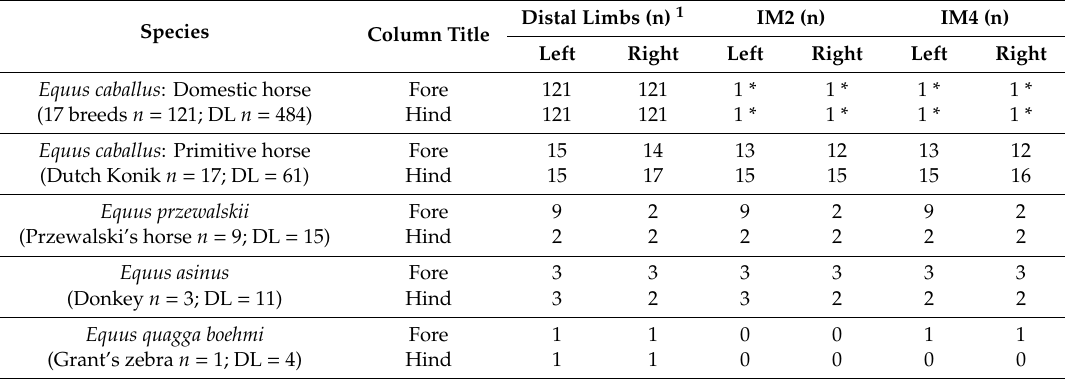
1 Note: Not all four limbs were available for some animals. * Denotes Bosnian Mountain Horse. IM2: Interosseous muscle II, IM4: Interosseous muscle